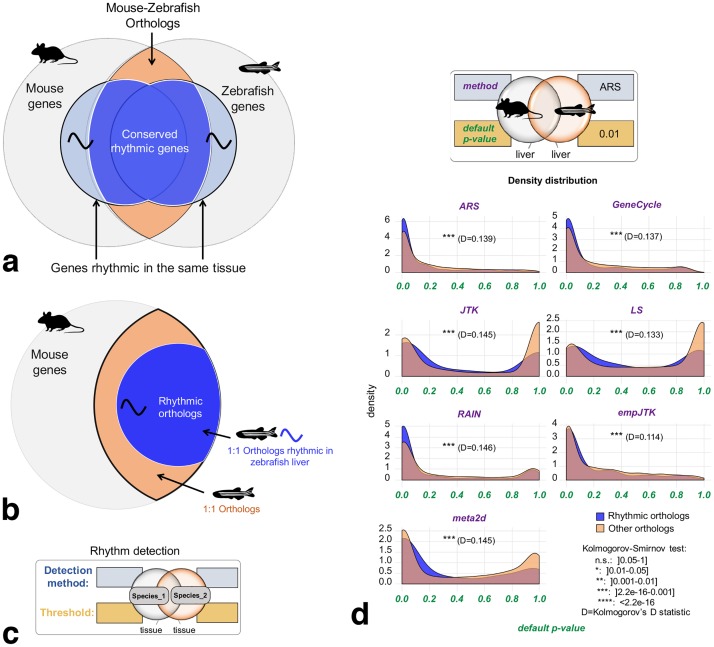
Signal of evolutionary conservation of rhythmic gene expression.Orthologous genes detected as rhythmic in the same organ of two species have a stronger statistical signal of rhythmicity than those not detected as rhythmic in at least one species. a) Mouse and zebrafish share orthologous genes, some of which are rhythmic in the homologous tissues. b) Method used for ortholog benchmarking, as in panel d: From all mouse genes, only mouse-zebrafish one-to-one orthologs are kept. Considering the liver, these orthologs are separated into two groups: genes for which the ortholog is detected as rhythmic in zebrafish liver, called rhythmic orthologs; and the remaining one-to-one orthologs. c) Chart providing the legends to inform about the method and the threshold used to call genes rhythmic for each condition (species and tissue). d)
p-values density distribution of rhythmic orthologs vs non-rhythmic orthologs obtained for the seven methods applied to mouse liver data. Mouse-zebrafish orthologs, that are detected rhythmic in zebrafish liver, are significantly more enriched in small p-values in mouse liver, for all methods (Kolmogorov-Smirnov test p-values < 0.001). Images credit: Anthony Caravaggi (mouse), Ian Quigley (zebrafish).